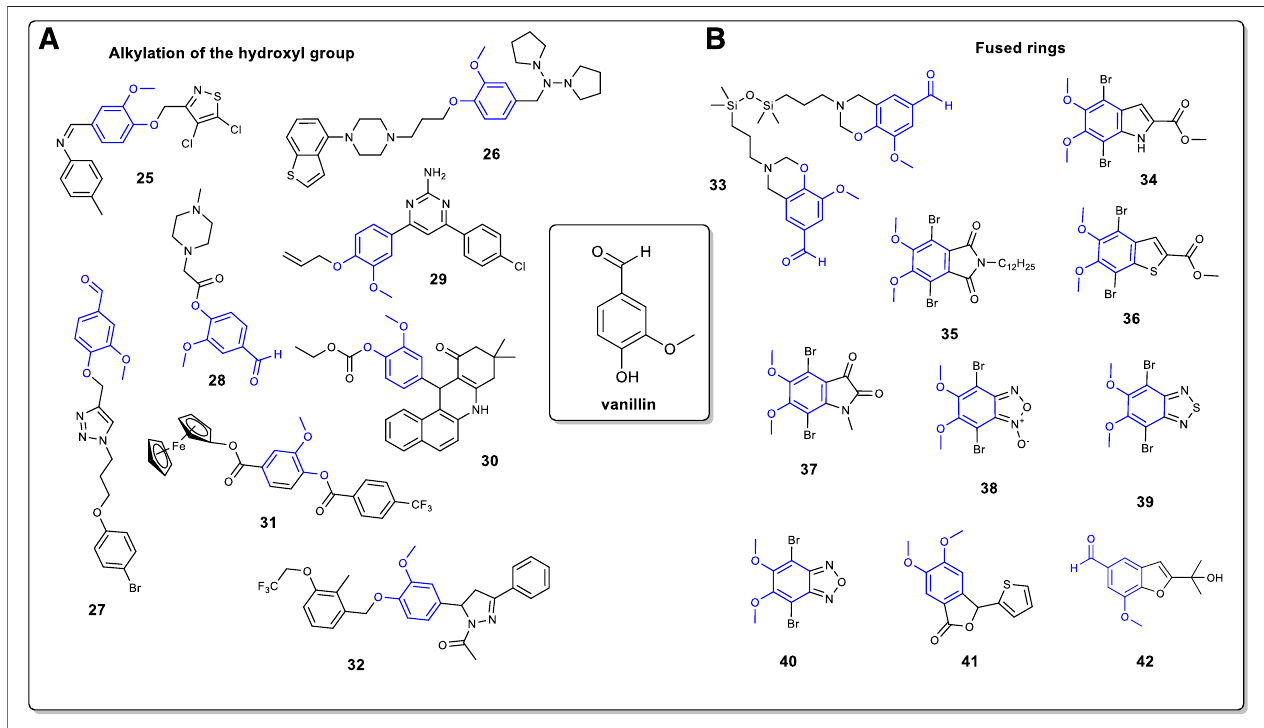
FIGURE 2 | (A) : Alkylation of the vanillin moiety through the hydroxyl functional group; (B) : Vanillin-based heterocyclic fused rings.